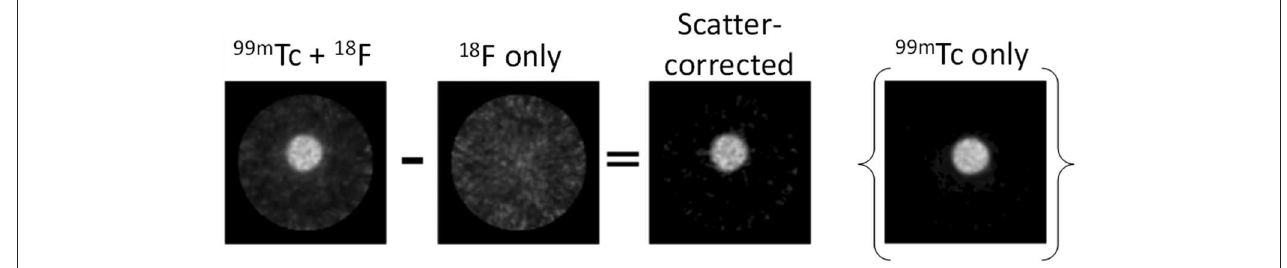
FIGURE 8 | Proof-of-concept for SPECT scatter data correction method. The 18 F-only scatter map image was subtracted from the 99m Tc + 18 F mixed-radionuclide image to achieve the final scatter-corrected image. The 99m Tc-only image is included for comparison.